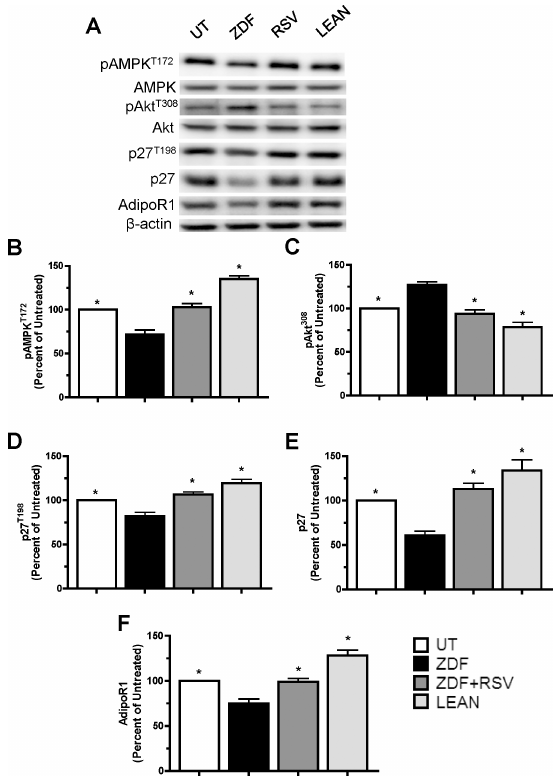
Fig 5. ZDF rats supplemented with RSV prevents the deleterious effectsof ZDF-CM on cell cycle proteins. A: Representative western blots for selectedproteins showingthe effects of treatment with